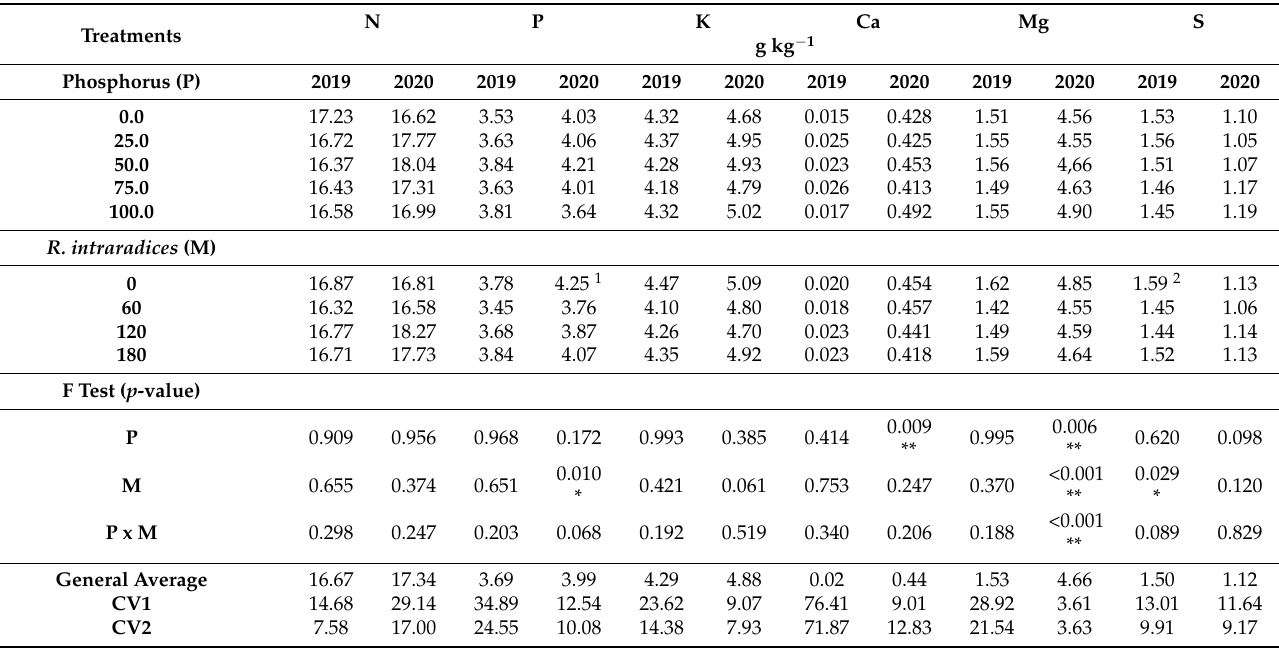
Table 3. Macronutrient contents in harvested corn grain as a function of P 2 O 5 doses and seed inoculation with Rhizoglomus intraradices .